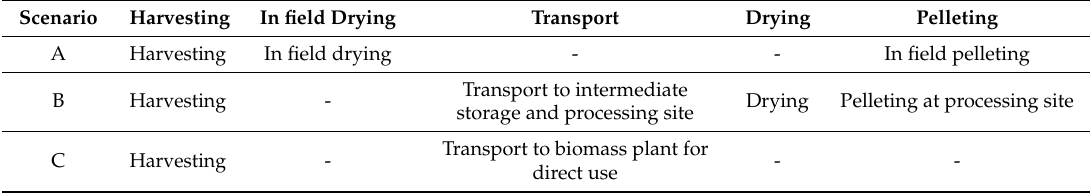
Table 2. Economic scenarios: Two possible pruning pellet production chains and direct use of chips.